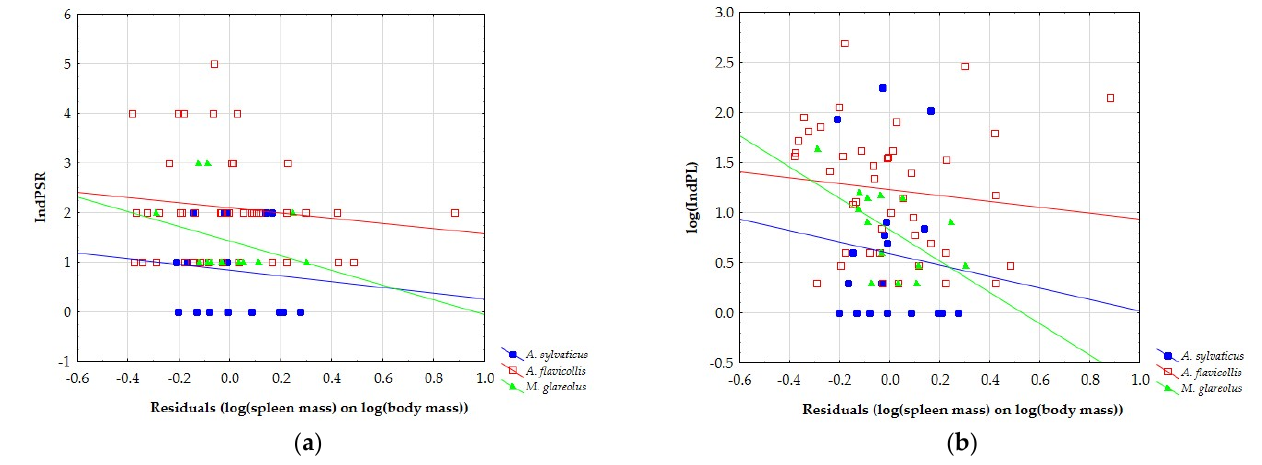
Figure 3. The relationship of spleen mass with ( a ) individual parasite species richness IndPSR and ( b ) individual parasite load (IndPL).